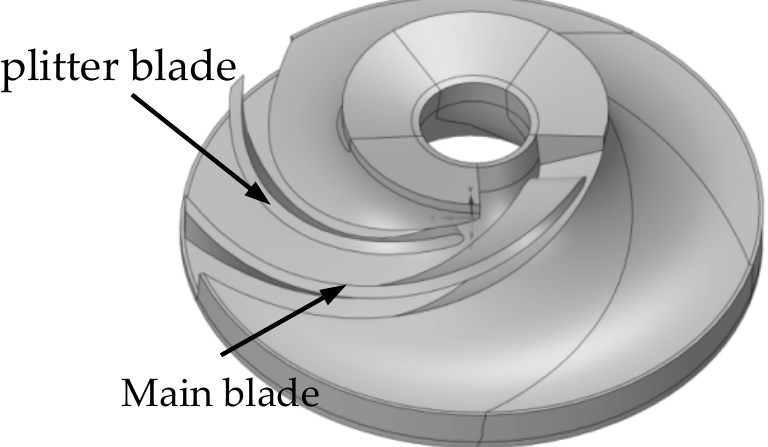
Figure 2. Impeller flow domain with splitter blades (Ref1).